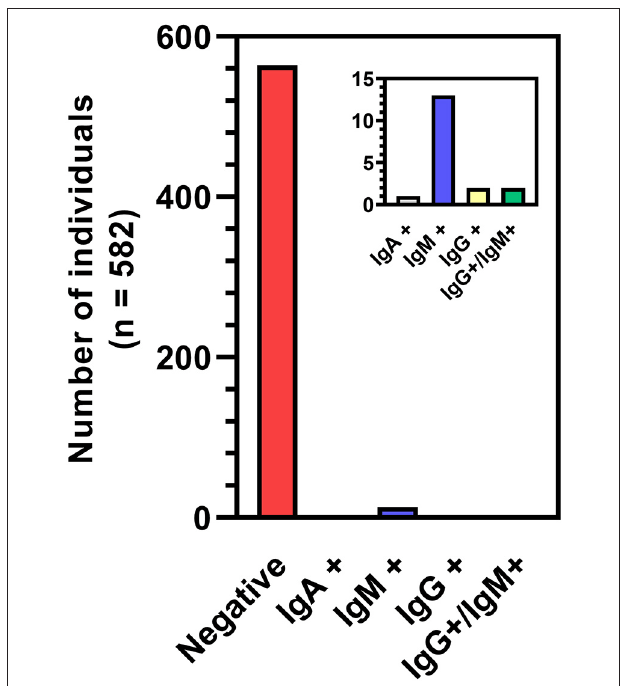
FIGURE 2 | Breakdown of seropositive participants based on W-ELISA. The two participants represented by the IgG + /IgM + bar had a sample test positive for both antibodies. All other positive participants tested positive to the same single antibody in one to four blood